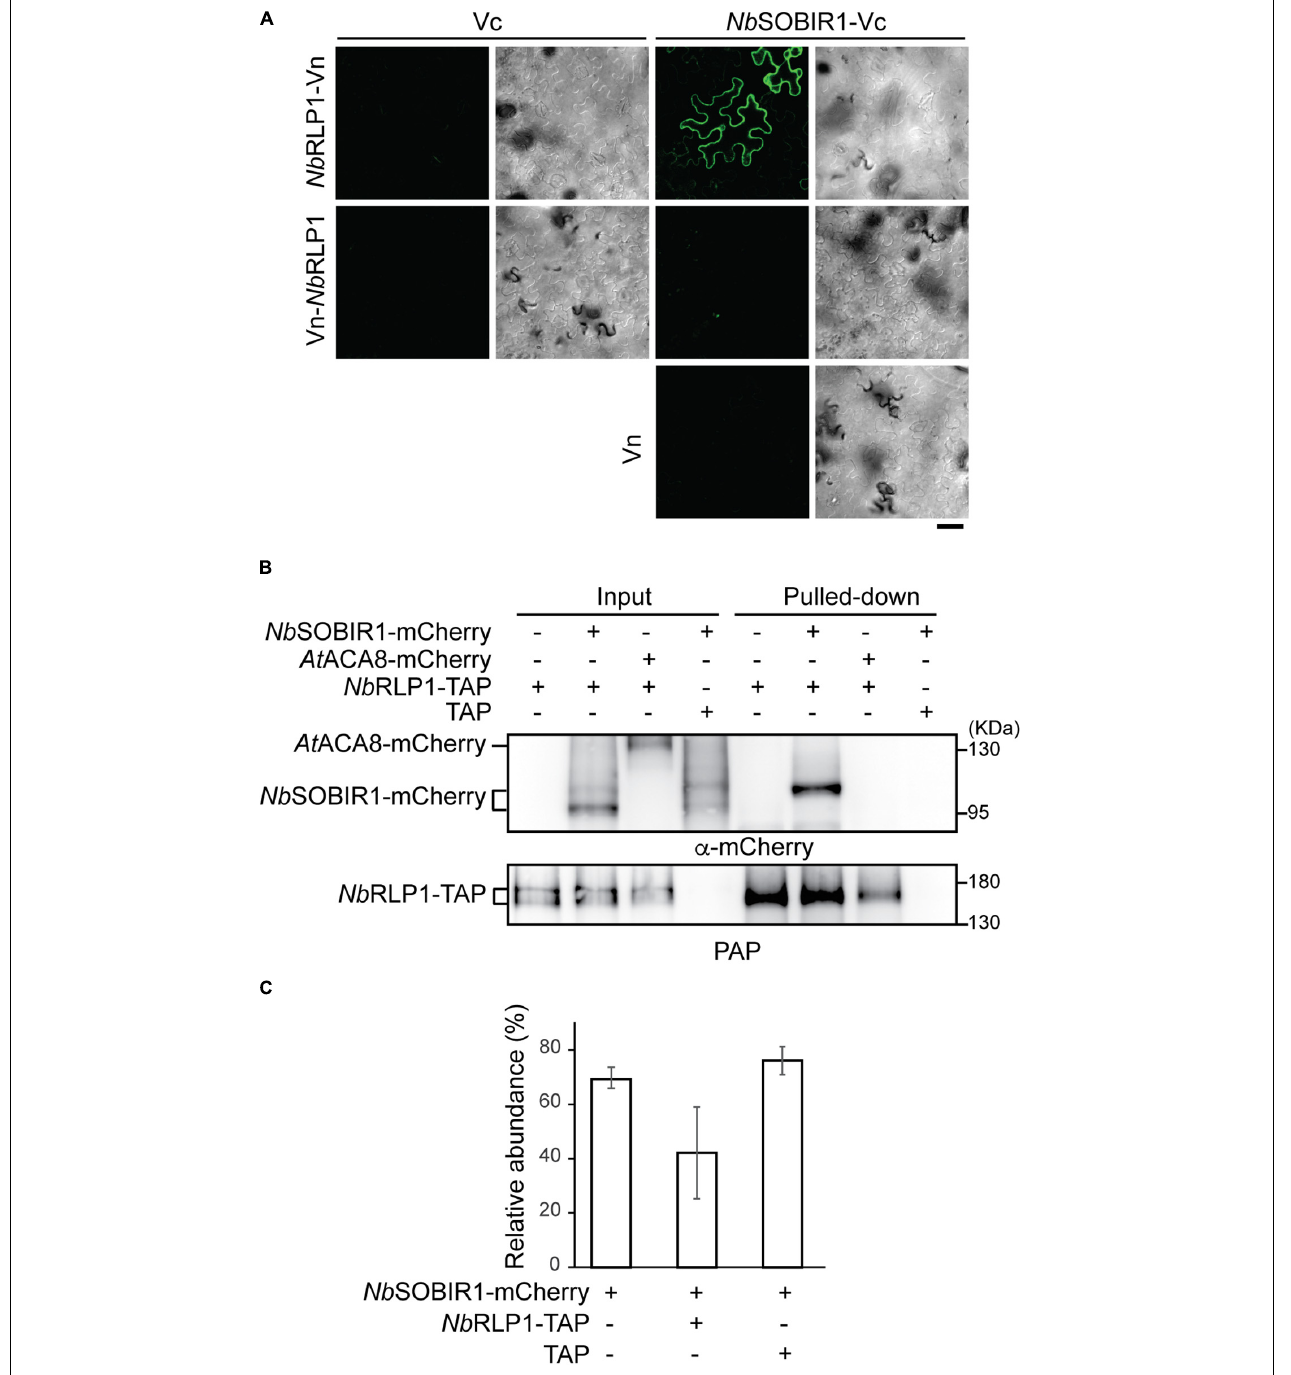
FIGURE 3 | Nb RLP1 interacts with Nb SOBIR1. (A) The carboxyl half of Venus protein (Vc) alone or fused to Nb SOBIR1 was coexpressed with the amino half of Venus (Vn) alone or fused to Nb RLP1 as indicated on the Nicotiana benthamiana leaves. Images were taken by Zeiss LSM880 confocal microscope. Complemented Venus fluorescence and differential interference contrast (DIC) images of the same area are shown. Scale bar, 40 µ m. (B) N. benthamiana leaves expressing Nb SOBIR1-mCherry, At ACA8-mCherry, Nb RLP1-TAP, or TAP as indicated were harvested and lyzed. The lysate (input) was subjected to pull-down by IgG Sepharose as described in the Materials and Methods section. The input and the bound (pulled-down) fractions were subjected to SDS-PAGE followed by the Western blot analysis with the use of anti-mCherry and PAP antibodies. (C) N. benthamiana leaves expressing Nb SOBIR1-mCherry, Nb RLP1-TAP, or TAP as indicated were lyzed and Nb SOBIR1-mCherry proteins in the lysate were subjected to SDS-PAGE followed by Western blot analysis with anti-mCherry antibody. The ratio of the upper Nb SOBIR1 band (with higher molecular mass) relative to the total Nb SOBIR1 (combining both the upper and lower bands of Nb SOBIR1) was plotted and compared. Data from three experimental repeats are shown as means ( ±